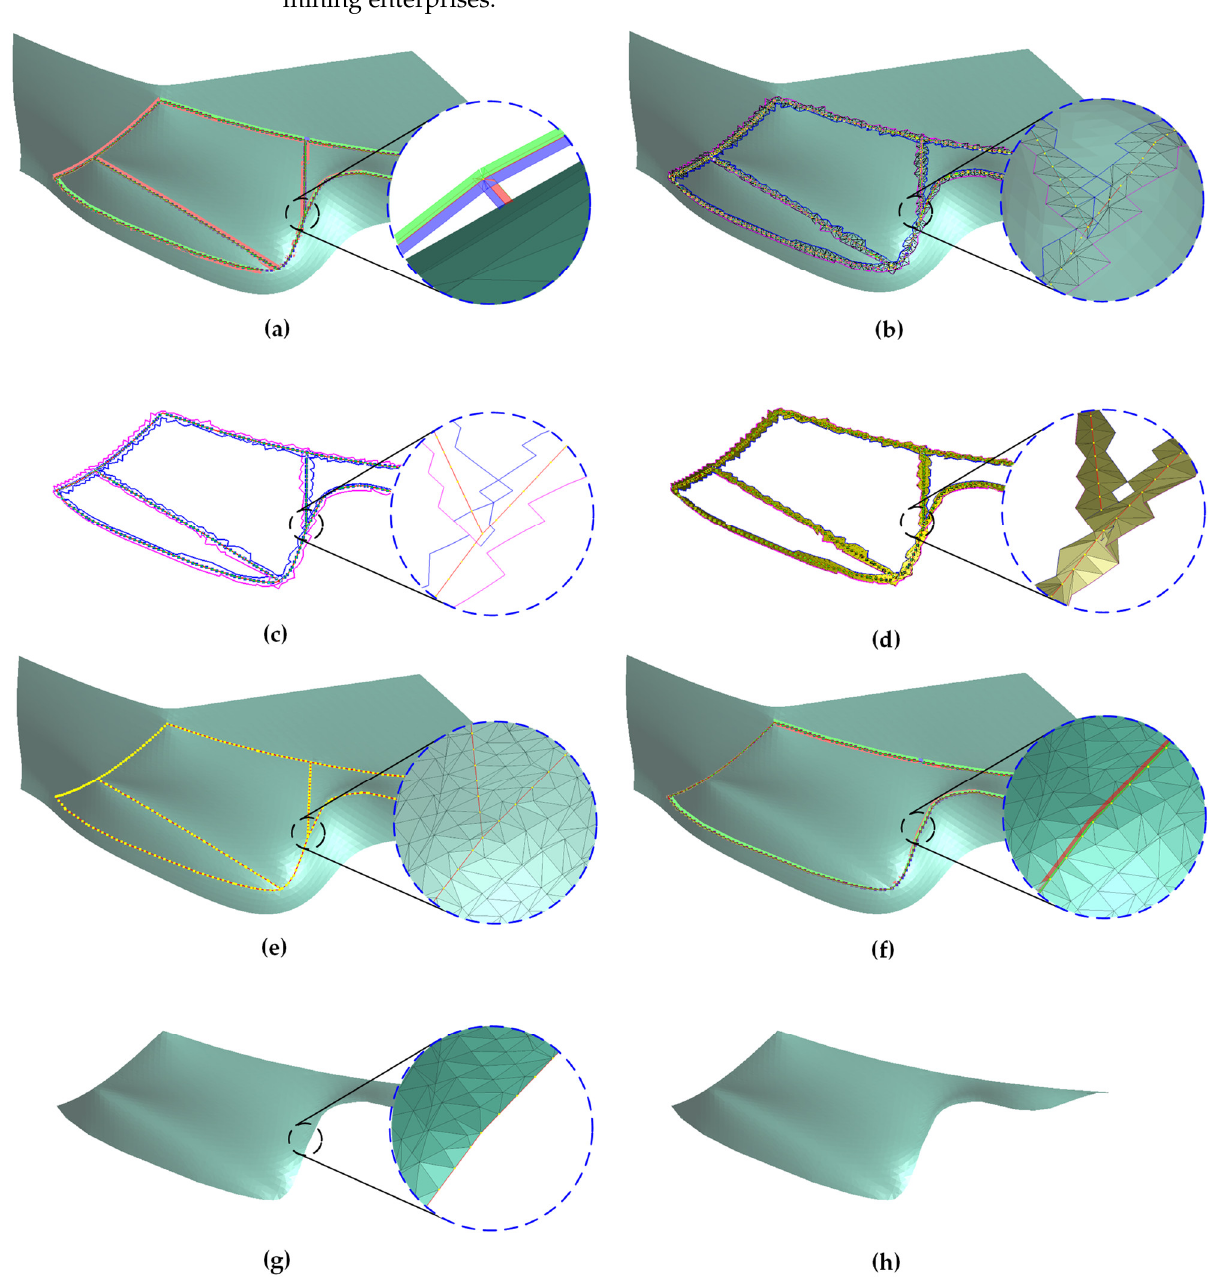
Figure 11. The first group test results of the snapping of feature polylines and clipping of the model boundary. ( a ) shows constraint polylines and implicit modeling results. ( b ) shows the process of constraint polyline projection and mesh matching. ( c ) shows the matched mesh boundaries. ( d ) shows the re-meshing of the matching meshes. ( e ) shows the results of mesh merging and normal consistency. ( f ) shows the boundary constraint polylines and the model after normal consistency. ( g ) shows the result of mesh boundary clipping. ( h ) shows the orebody model after mesh